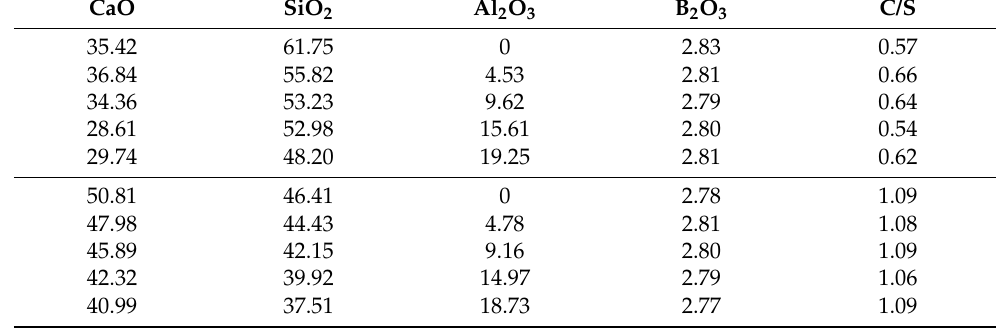
Table 3. Pre-melting slag components with B 2 O 3 , as determined from X-ray fluorescence and inductively coupled plasma analysis, mass%.